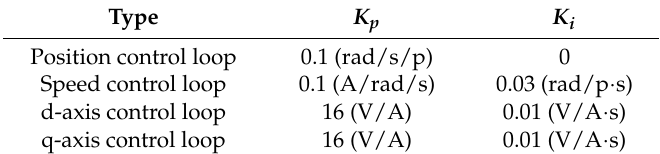
Table 2. The parameters of the proposed control system.